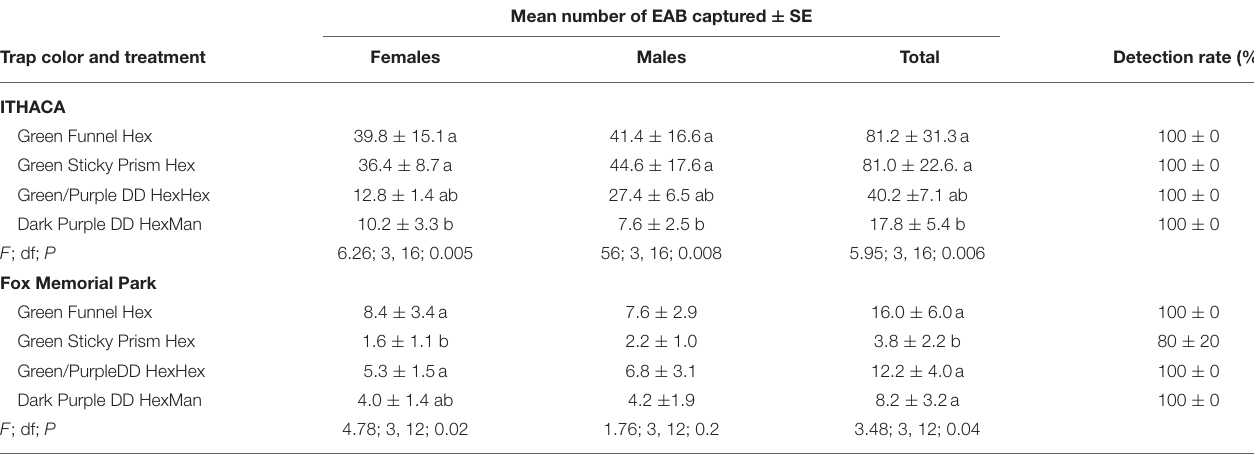
TABLE 4 | Mean number ( ± SE) of A. planipennis captured and detection rate (percentage of traps that captured at least one beetle) in Experiment 3 that compared traps of different types and colors at a woodlot near Ithaca, Gratiot County, Michigan with a high infestation level and at Fox Memorial Park, Eaton County, Michigan with a very low infestation level in 2014.